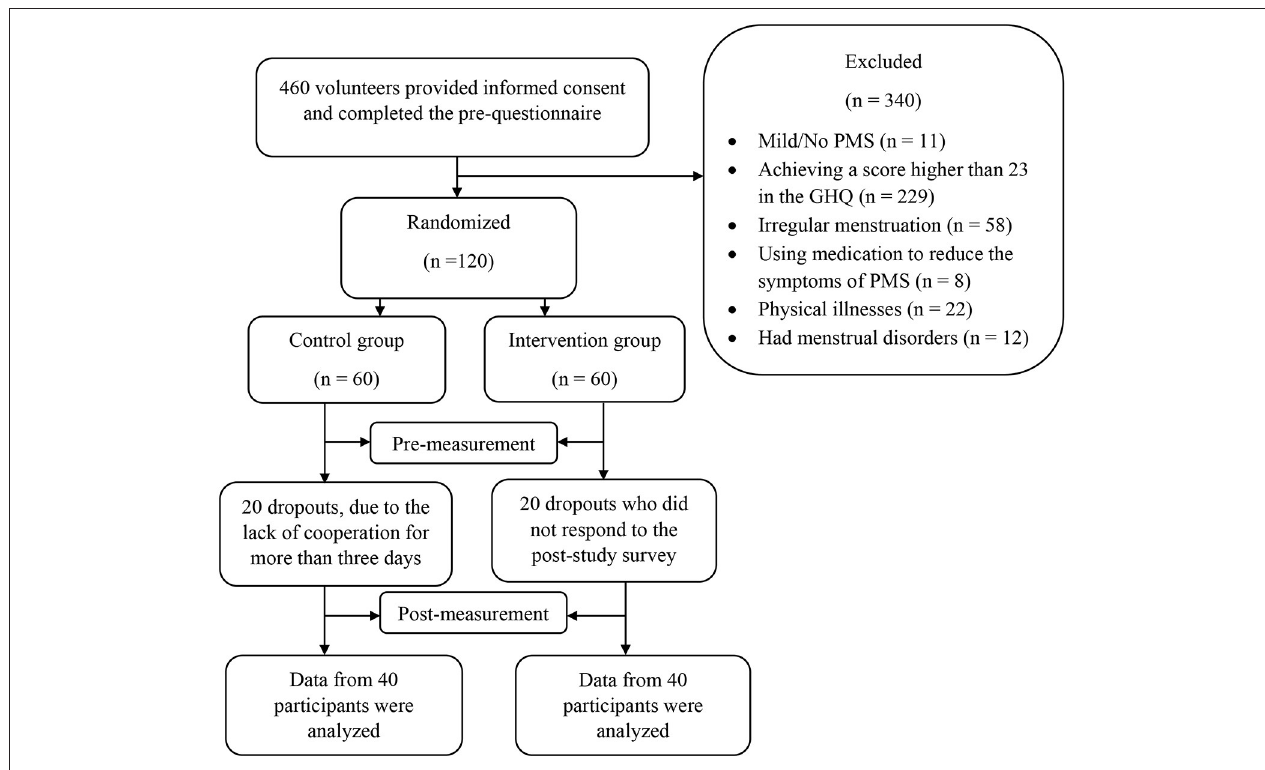
FIGURE 1 | Process chart from recruitment to